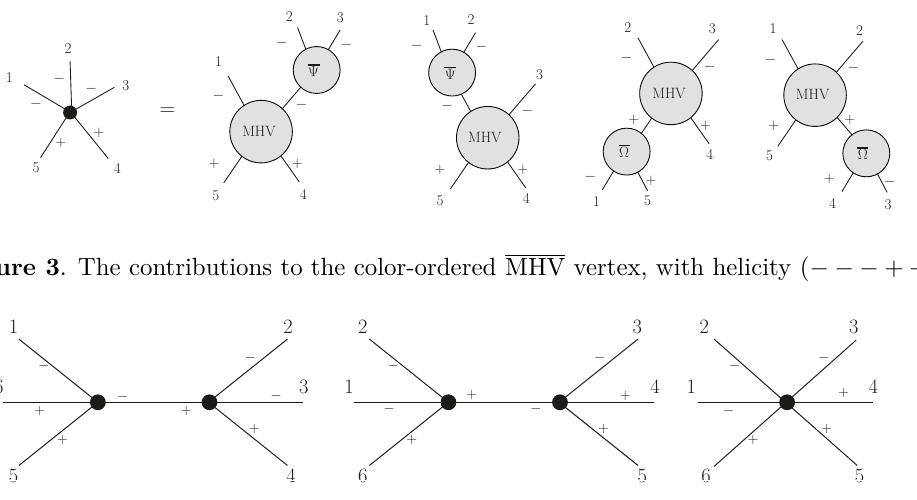
Figure 4 . Diagrams contributing to the 6-point NMHV amplitude ( − − − + ++)